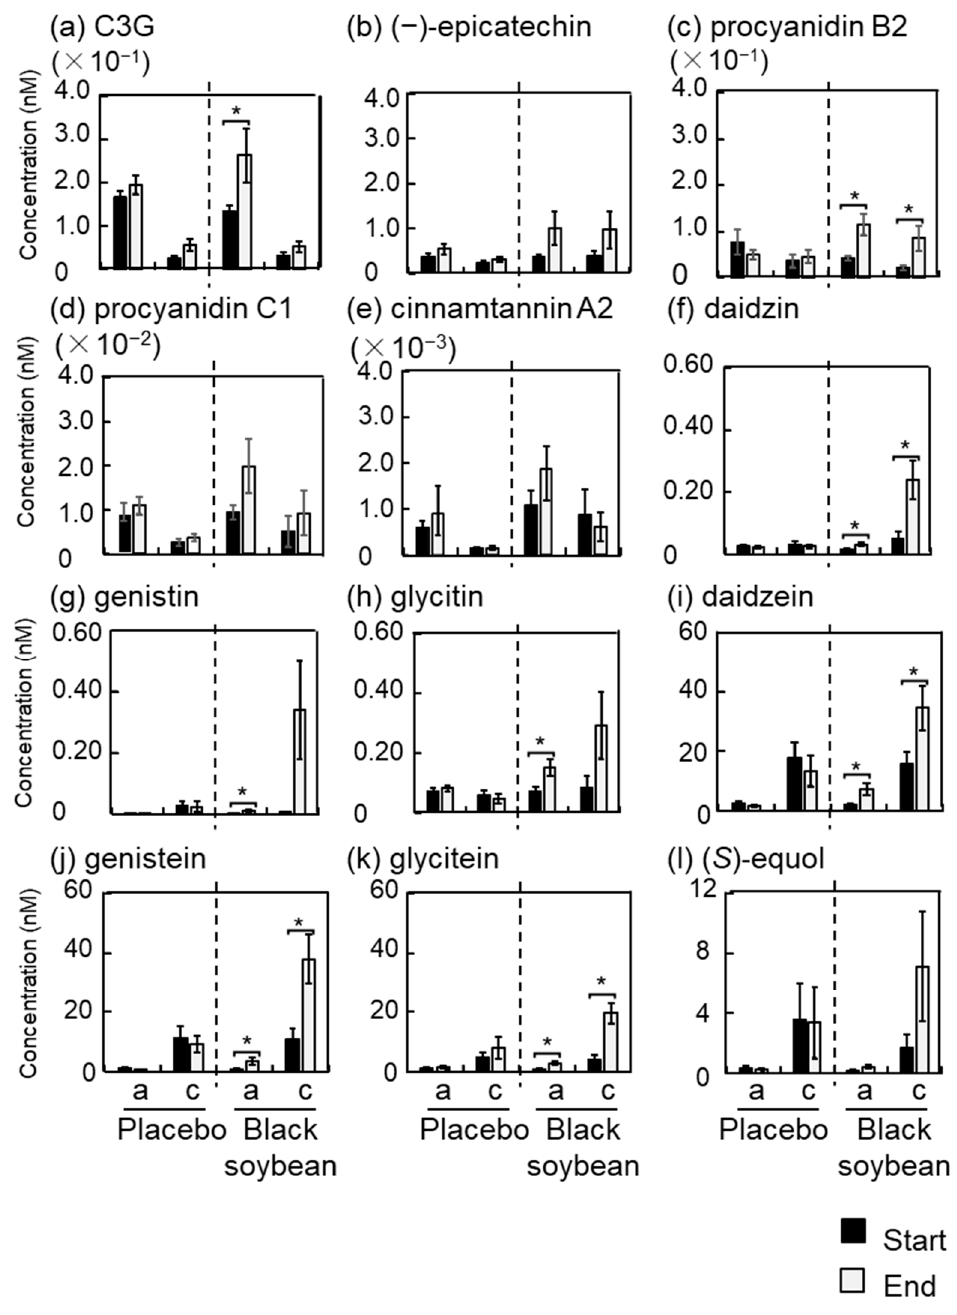
Figure 2. The effect of black soybean consumption on polyphenol concentration in the urine. a; aglycone form, c; conjugates form. Each panel showed ( a ) C3G, ( b ) ( − )-epicatechin, ( c ) procyanidin B2, ( d ) procyanidin C1, ( e ) cinnamtanninA2, ( f ) daidzin, ( g ) genistin, ( h ) glycitin, ( i ) daidzein, ( j ) genistein, ( k ) glycitein, and ( l ) (S)-equol, respectively. The results are represented as the means ± standard deviation. * p < 0.05 vs. start by Welch ’ s t test .